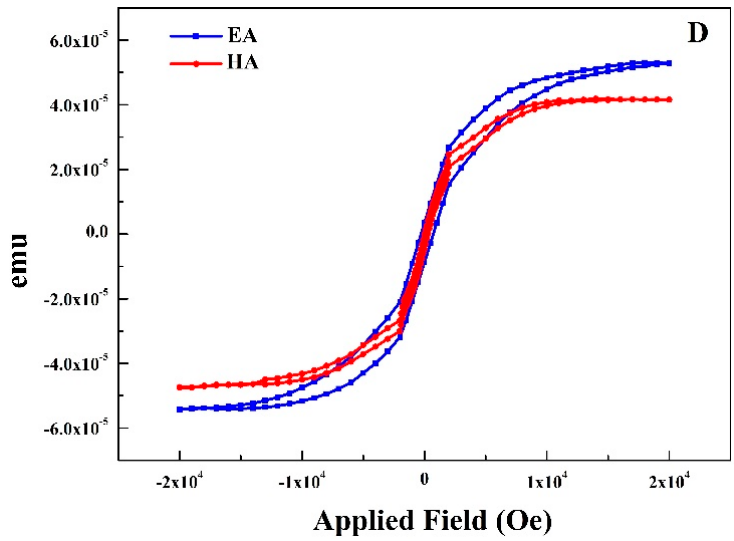
Figure 9. Magnetization measurements of the FeN thin film sputtered on both sides.